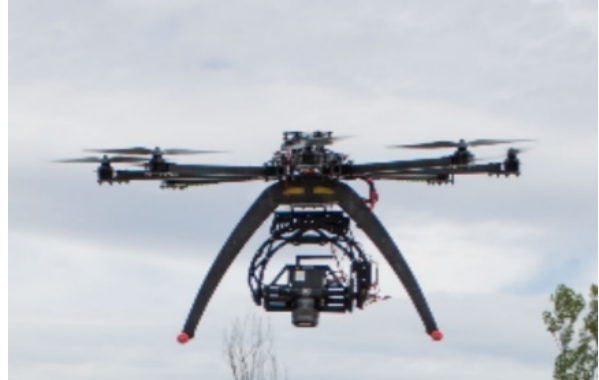
Figure 3. The ISTI-CNR drone: the digital camera is hosted by the gimbal, a mechanical support able to stabilize the image acquisition against vibrations or unexpected